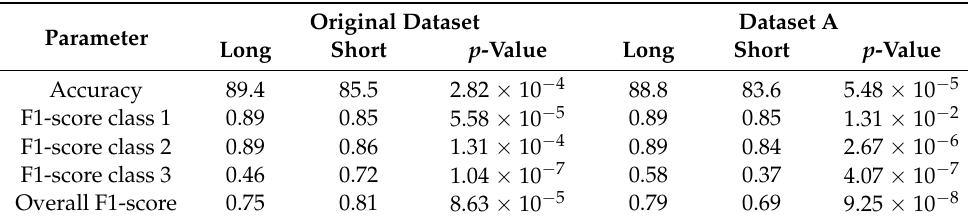
Table 6. Overview of the results for the long time window (4 s, called Long) and the short time window (1 s, called Short) for datasets original and A. No PCA was applied. The p -value is provided to indicate whether the two values are significantly different ( p -value < α , p -value < 0.05) or not. Significance was tested with a paired samples t -test with a two-tailed